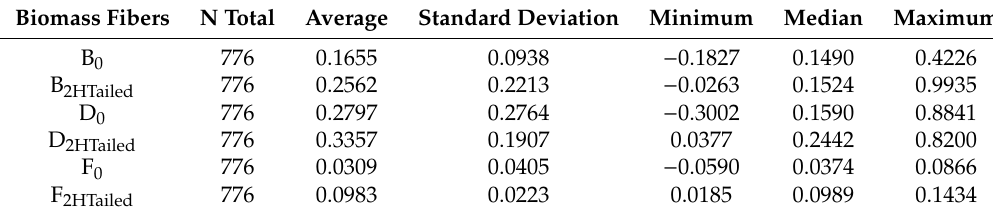
Table 4. Average Sound Absorption of Biomass Fiber Materials with Multiple Tailed Cavities. Biomass Fibers N